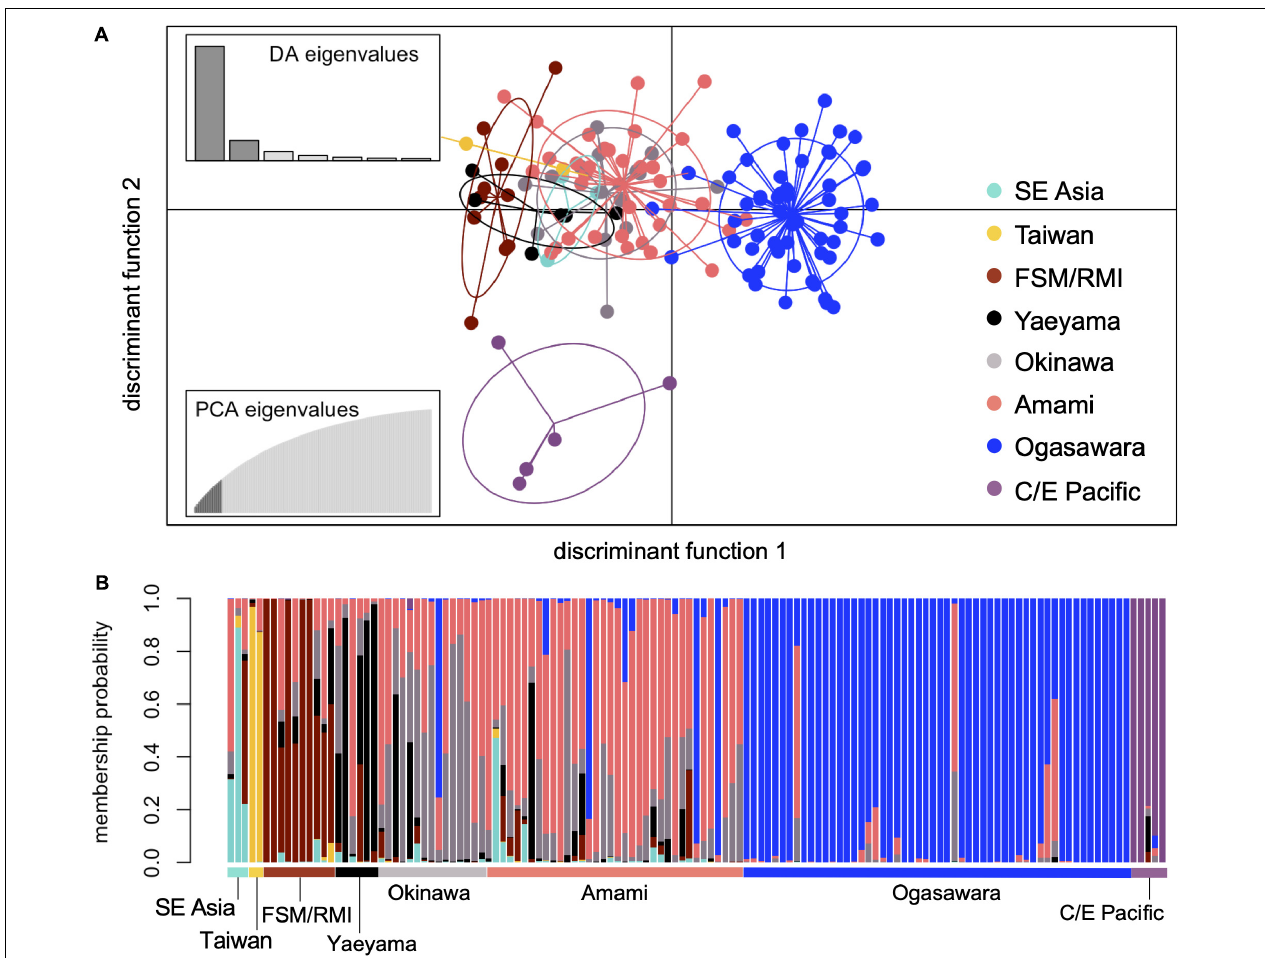
FIGURE 2 | Scatterplot showing the structure patterns of nesting populations (A) and compoplot showing the admixed pattern of each individual (B) . Both structures were generated from discriminant analysis of principal components (DAPC) based on the eight regional nesting groups and 629 SNPs.